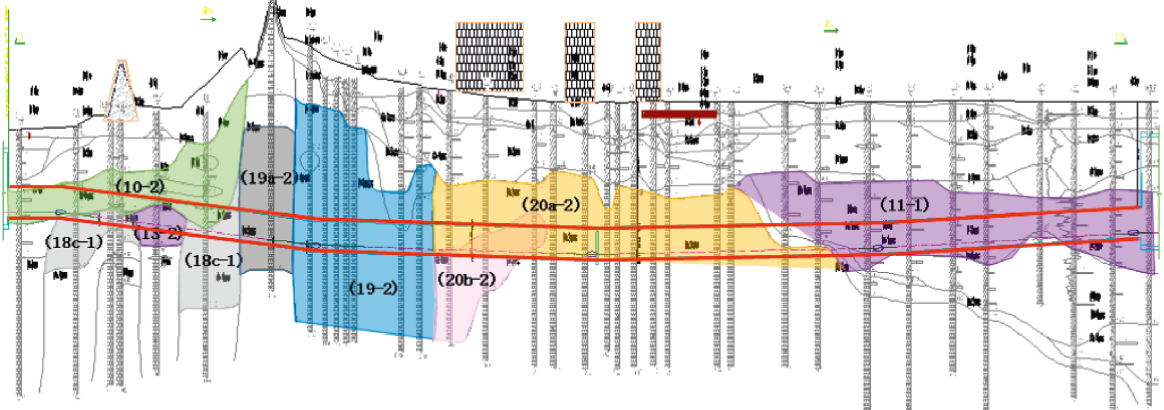
Figure 4: Geological profile of shield crossing on the right